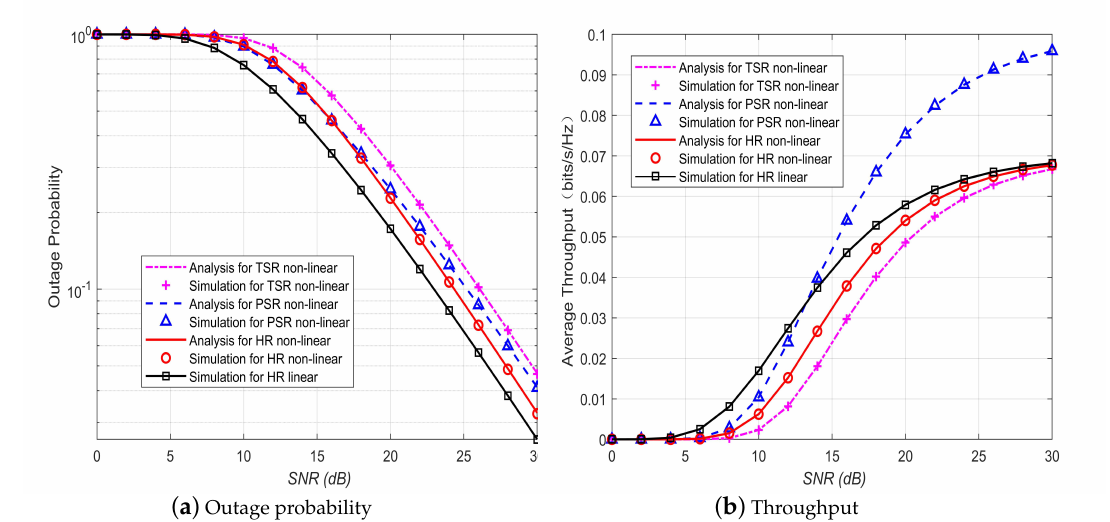
Figure 6. Performance comparison of different energy harvesting